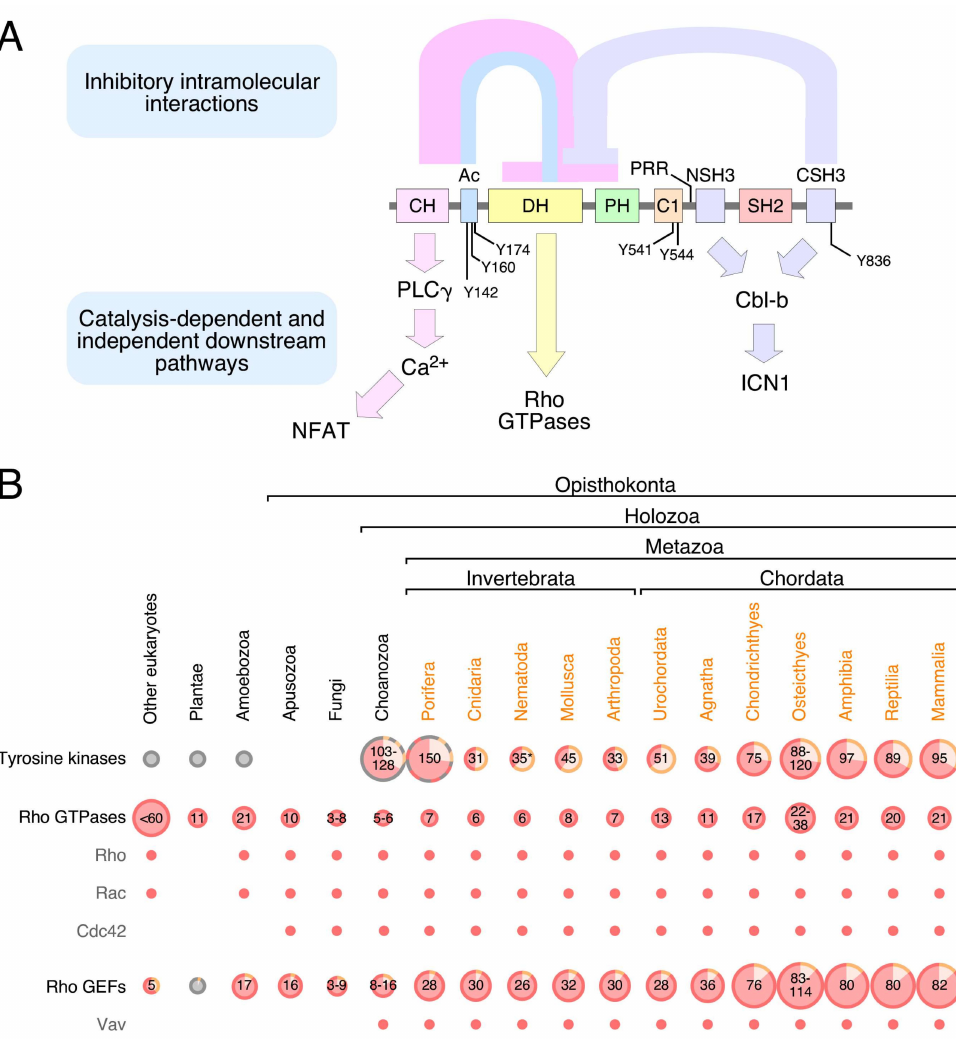
Figure 1. Structure, regulation, e ff ector functions, and evolution of Vav proteins. ( A ) Depiction of the structure, the intramolecular interactions that control the signaling output (top), the main regulatory phosphosites (using the amino acid sequence corresponding to mouse Vav1), and the main downstream pathways (bottom) of mammalian Vav proteins. Abbreviations for the domains and proteins depicted in the figures have been described in the main text. ( B ) Evolution of PTKs, Rho GTPases, and Rho GEFs. The size of the circles is proportional to the number of members present in the indicated protein families and taxonomic groups. Please note that in some species (e.g., amoebozoans, plants) there is tyrosine kinase activity carried out nonspecifically by serine / threonine protein kinases (gray circles). Proteins with equivalent function but with non-metazoan domain combinations are also present in other species (gray circles). In the case of PTKs, the percentage of transmembrane (light red color) and cytoplasmic (light brown color) versions is depicted in the figure. For Rho GEFs, the percentage of members belonging to the DH and Dock subclasses is indicated using light red and light brown colors, respectively. In the case of Rho GTPases and Rho GEFs, the presence of specific family members (Rho, Rac, Cdc42, Vav) is indicated by small light red dots. This figure integrates information